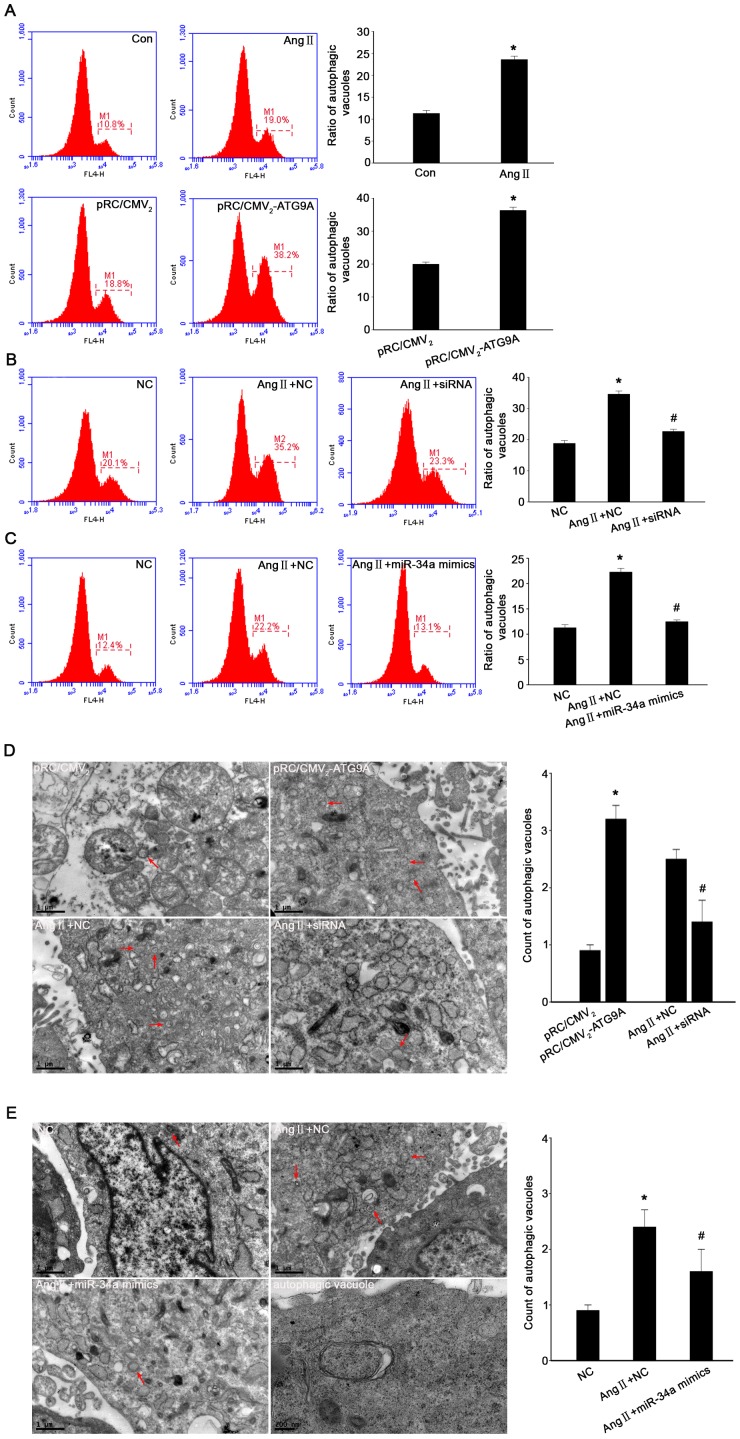
Effects of ATG9A and miR-34a expression on Ang II-induced autophagic activity in cardiomyocytes.(A) Flow cytometry. The autophagic vacuoles were detected by using flow cytometry with an anti-autophagy marker protein (LC3) in the cardiomyocytes. The graph summarizes the data of flow cytometry. *P<0.05 compared with Control group. (B) Flow cytometry. The graph summarizes data from the flow cytometry. *P<0.05 compared with NC group, #P<0.05 compared to Ang II + NC. (C) Flow cytometry. The graph summarizes data from the flow cytometry. *P<0.05 compared with NC group, #P<0.05 compared to Ang II + NC. (D) TEM. The autophagic vacuoles were detected and calculated by transmission electron microscopy (as indicated by the arrows). Magnification of images: ×13500. The graph is the quantitative data from the transmission electron microscopy. Data are presented as means ± SEM *P<0.05 compared with Control group; #P<0.05 compared to Ang II + NC. (E) TEM. Magnification of images: ×13500 and ×46000, respectively. The graph is the quantitative data from the transmission electron microscopy. Data are presented as means ± SEM *P<0.05 compared with NC group; #P<0.05 compared to Ang II + NC.